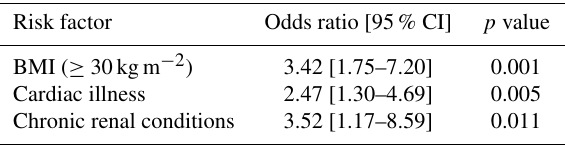
Table 4. Risk factors for early-onset deep surgical site infection.